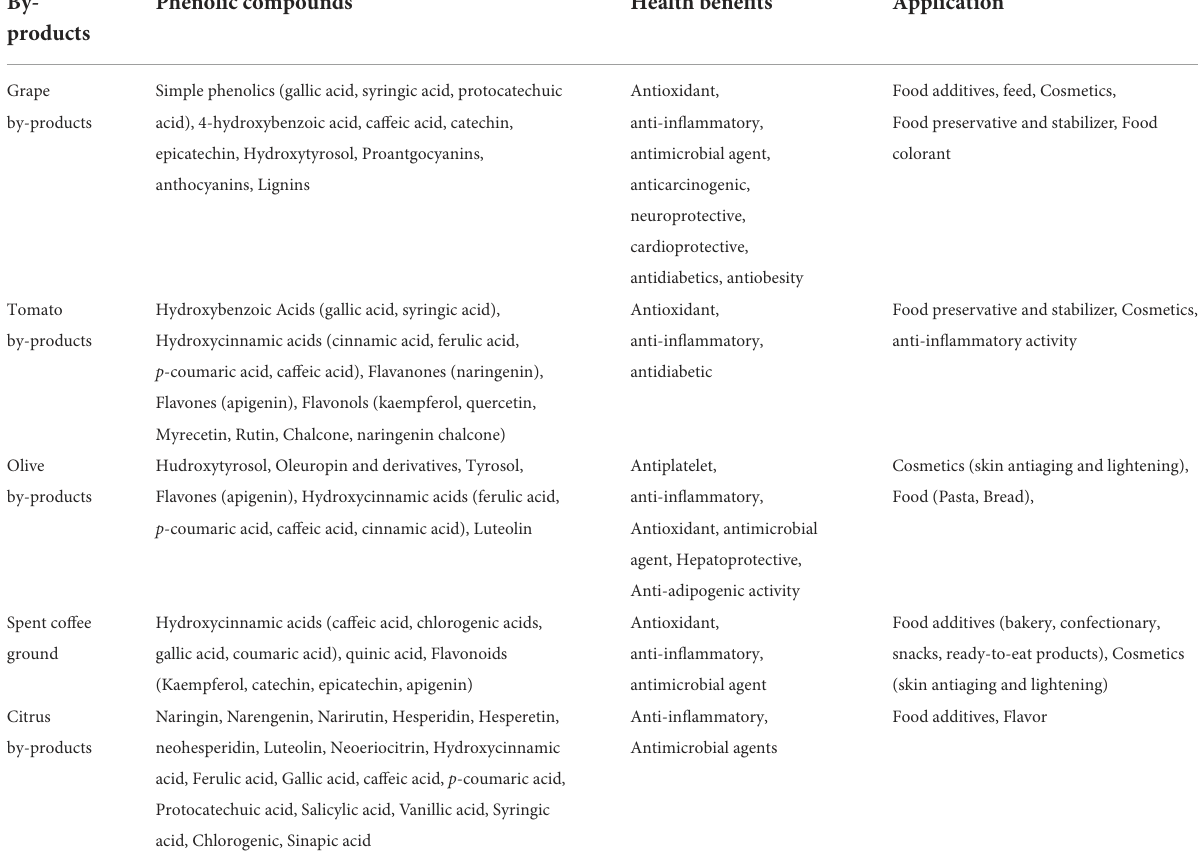
TABLE 1 Phenolic compounds recovered from by-products, health effects and their